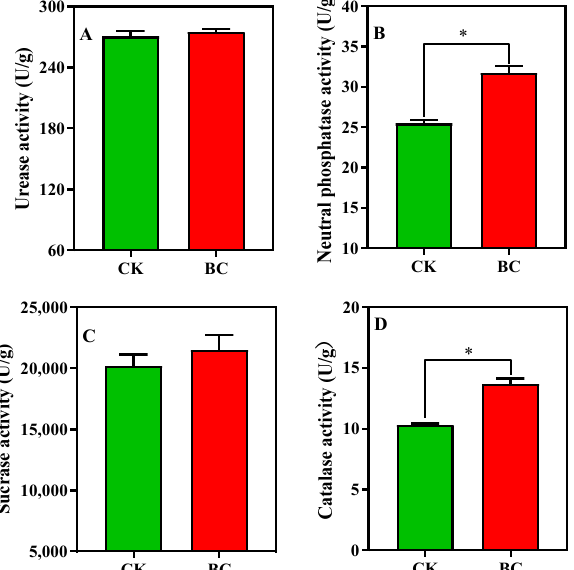
Figure 2. Effects of biochar on soil enzyme activities (( A ), Urease activity; ( B ), Neutral phosphatase activity; ( C ), Sucrase activity; ( D ), Catalase activity) in dry direct-seeded rice field. CK, conventional fertilizer; BC, biochar with conventional fertilizer. The error line represents the standard error ( n = 6). * Indicates a significant difference between CK and BC treatments ( p < 0.05).